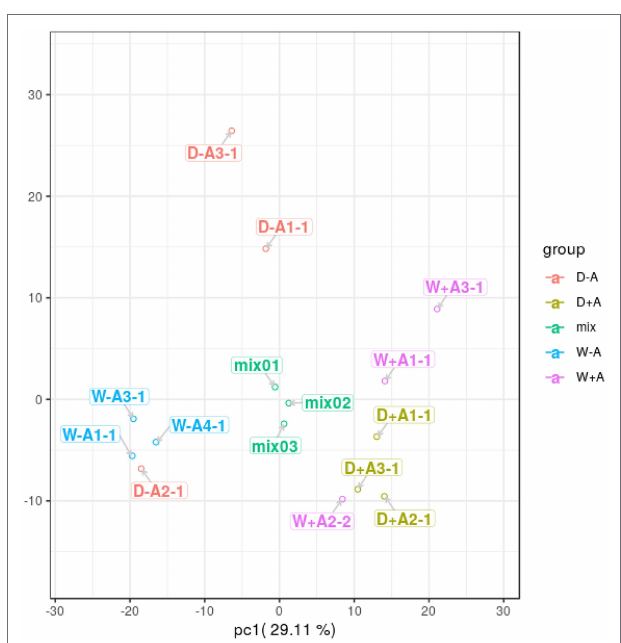
FIGURE 2 | Principal component analysis of metabolites in roots of trifoliate orange seedlings under well-watered and drought stress conditions after inoculation with Rhizophagus intraradices . Abbreviation: W + A, inoculation with R . intraradices under well-watered conditions; W-A, inoculation without R . intraradices under well-watered conditions; D + A, inoculation with R . intraradices under drought stress conditions; D-A, inoculation without R . intraradices under drought stress conditions; mix, quality control